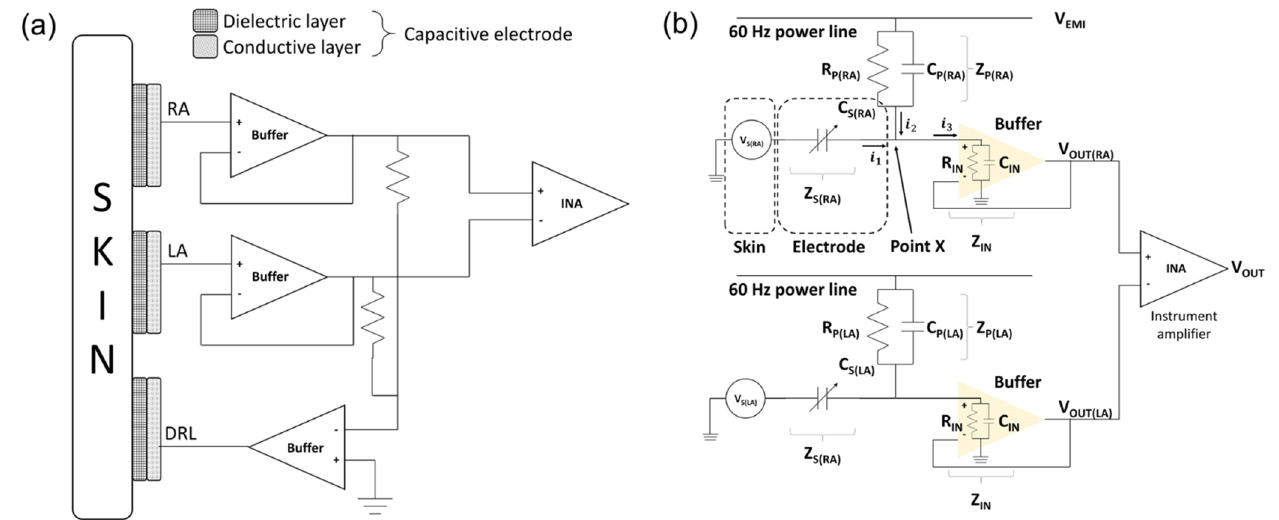
Figure 4. Schematic of skin–electrode interface. ( a ) Mechanical connection between electrode and circuit and ( b ) electrical circuit model of skin–electrode interface.